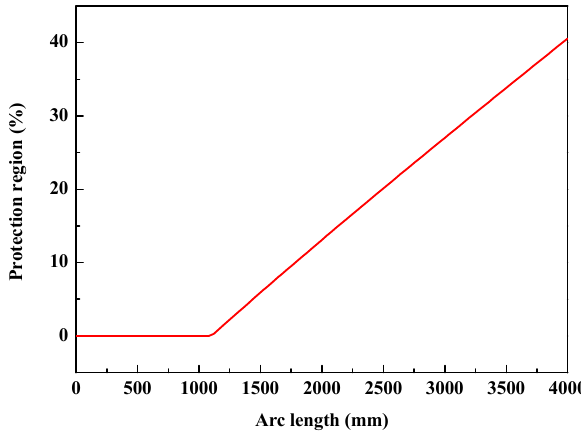
Figure 12. Influence of arc length on protection region of arcing horn.